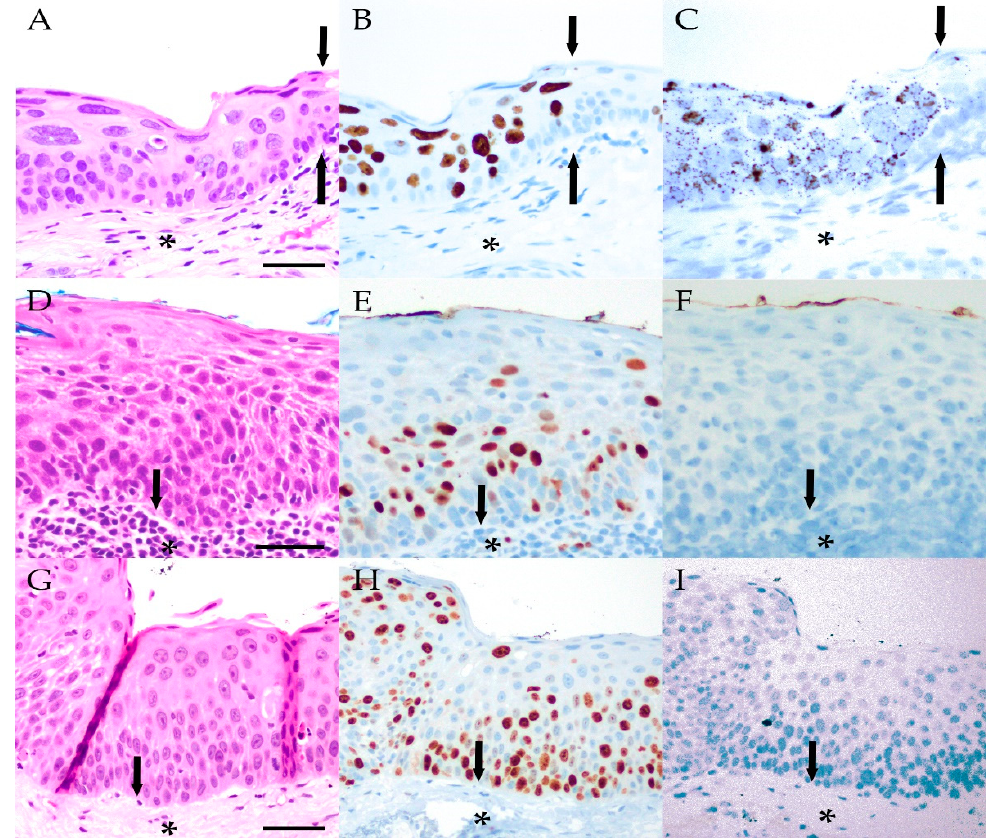
Figure 3. Representative images from the periphery of an H&E-stained CIN from Case 39 showing the transition to non-neoplastic conjunctiva ( A ) (scale bar: 25 μ M). Increased nuclear immunolabeling for Ki67 within the neoplastic epithelium ( B ) and corresponding RNA in-situ hybridization demonstrating positivity for high-risk HPV within the same dysplastic cells ( C ). Arrows in A–C mark the border between CIN and adjacent conjunctiva with non-dysplastic epithelium on the right side of each panel negative for Ki67 and HPV. The underlying substantia propria, containing blood vessels and inflammatory cells, is marked by asterisks and is negative for HPV. Representative images of an H&E-stained CIN from Case 40 ( D ) (scale bar: 25 μ M) and cCIS from Case 44 ( G ) (scale bar: 25 μ M) with arrows pointing to the epithelial base and asterisks in the underlying substantia propria. Increased nuclear immunolabeling for Ki67 within the neoplastic epithelium ( E , H ) and the corresponding RNA in-situ hybridization, which were both negative for high-risk HPV ( F , I ).